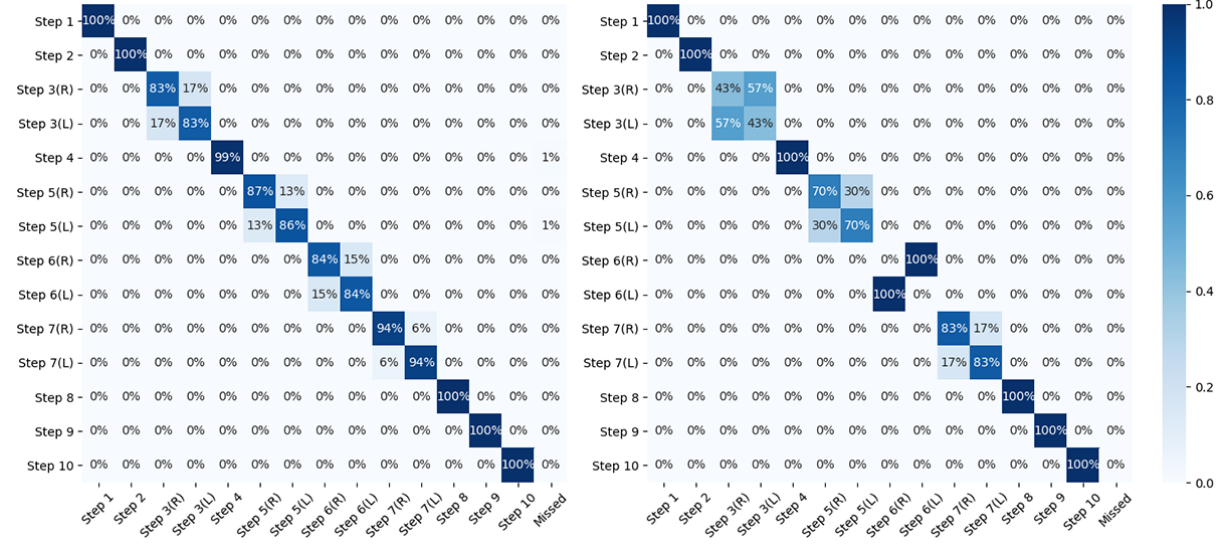
Figure 5. Confusion matrix showing the order of steps in hand hygiene sessions: all participants (left) and participant 8 (right). x-axis: performed step; y-axis: excepted step. L: left; R: right.